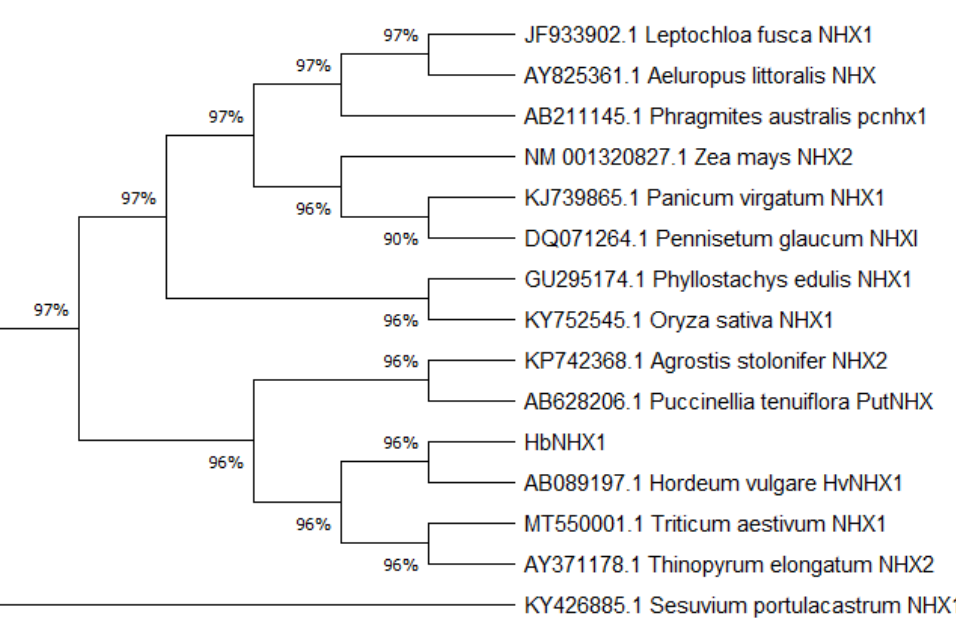
Figure 4. Structural analysis of HbNHX1 protein.The topological structure of the HbNHX1 protein was analyzed using TMHMM software (https://dtu.biolib.com/DeepTMHMM, accessed on 3 March 2020). The hydrophobic sequence with 13 transmembrane regions is shown in the large rectangle.